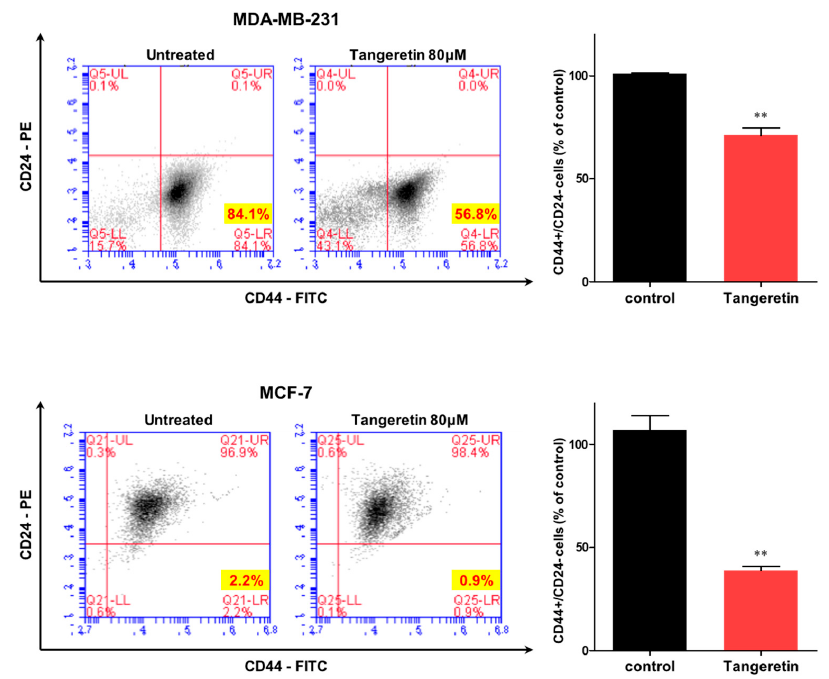
Figure 6. The effect of tangeretin on the CD44 high /CD24 low cell proportion. The CD44 high /CD24 low subpopulation within an MDA-MB-231 and MCF-7 cell population treated with tangeretin (80 μ M) or DMSO for 24 h was analyzed by flow cytometry. For flow cytometry analysis, 2 × 10 4 cells were acquired. The gating was based on the binding of an antibody without tangeretin (red cross). The data from triplicate experiments are represented as the mean± SD; ** p < 0.01.